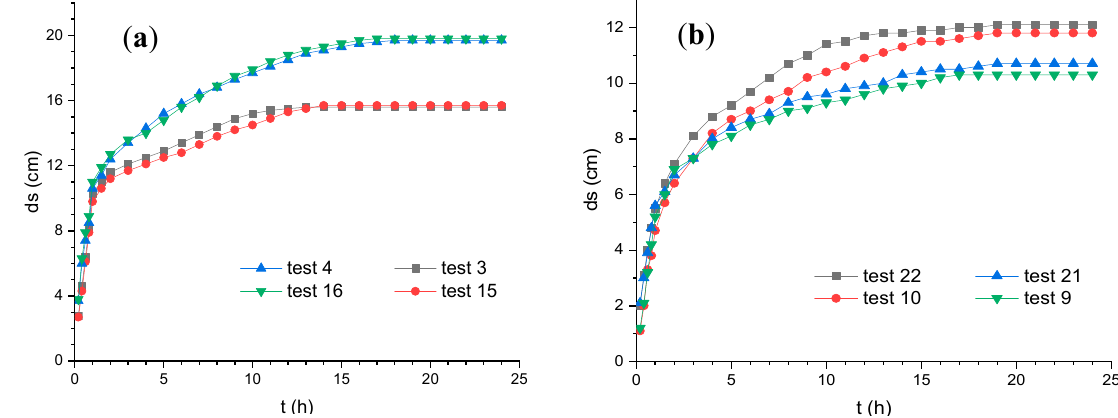
Figure 4. Time evolution of local scour depth ( a ) for shape S 2 : test 3 ( D p = 5 cm, d 50 = 0.71 mm), test 4